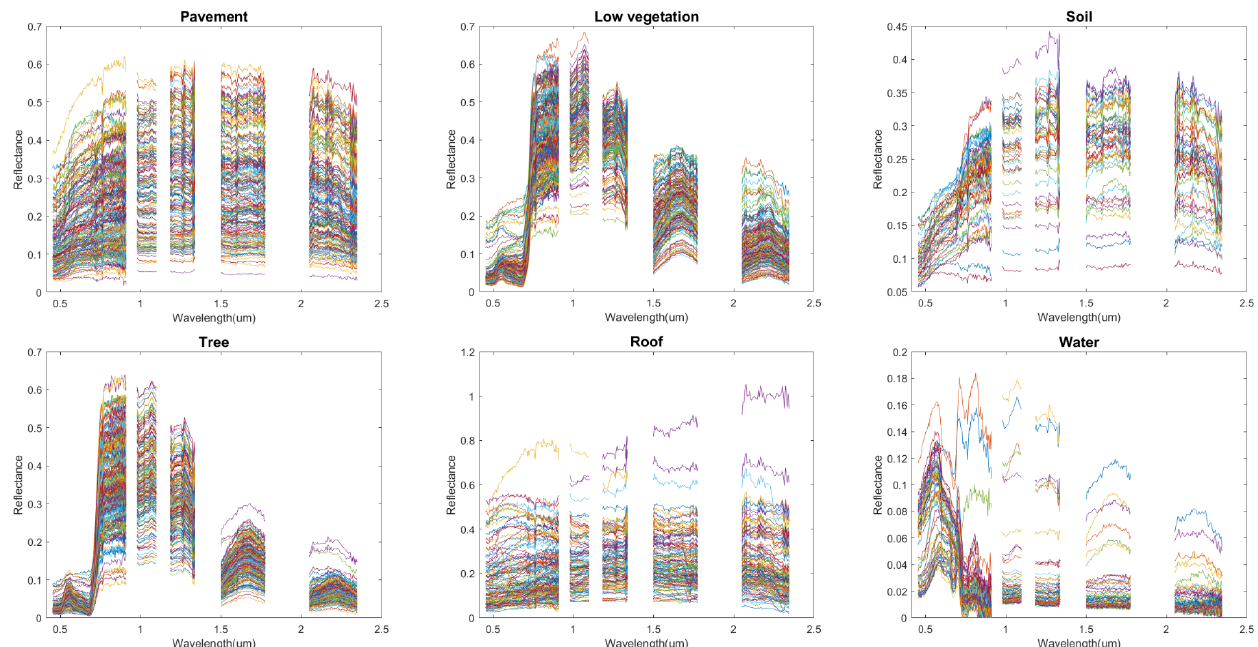
Figure 4. The endmember spectra for each land cover